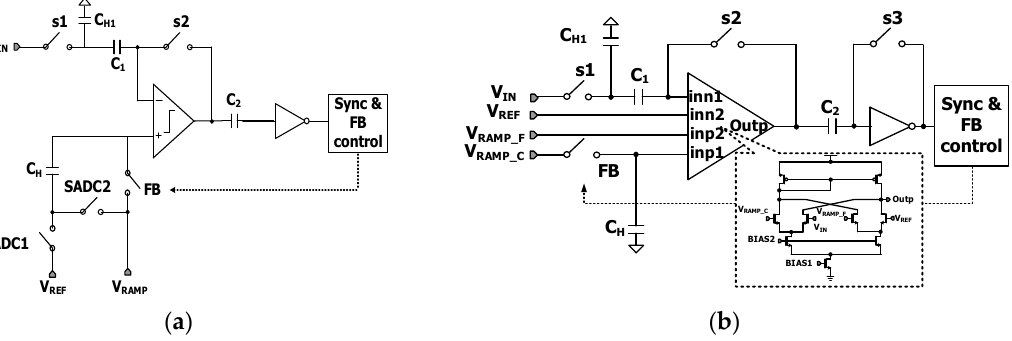
Figure 6. Circuit diagram of ( a ) conventional TSSS ADC with analog CDS block and ( b ) proposed TSSS ADC with DDA.